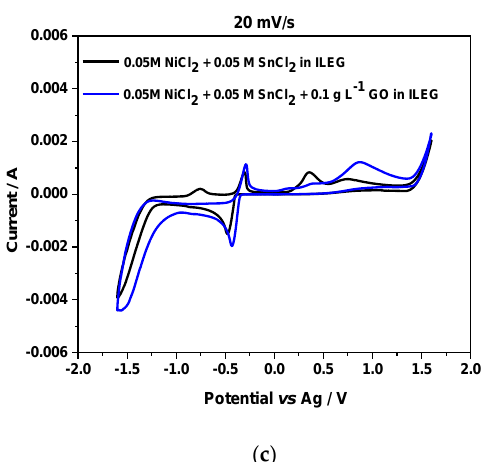
Figure 2. Cyclic voltammograms (CVs) on a glassy carbon (GC) electrode at 75 °C for: ( a ) multiple cycles for ILEG-GO electrolyte system at 100 mV/s; ( b ) the first cycle for Sn-GO, Ni-GO, NiSn-GO and ILEG-GO electrolyte systems and ( c ) comparative CVs for NiSn systems in the absence and in the presence of GO, at 20 mV/s.